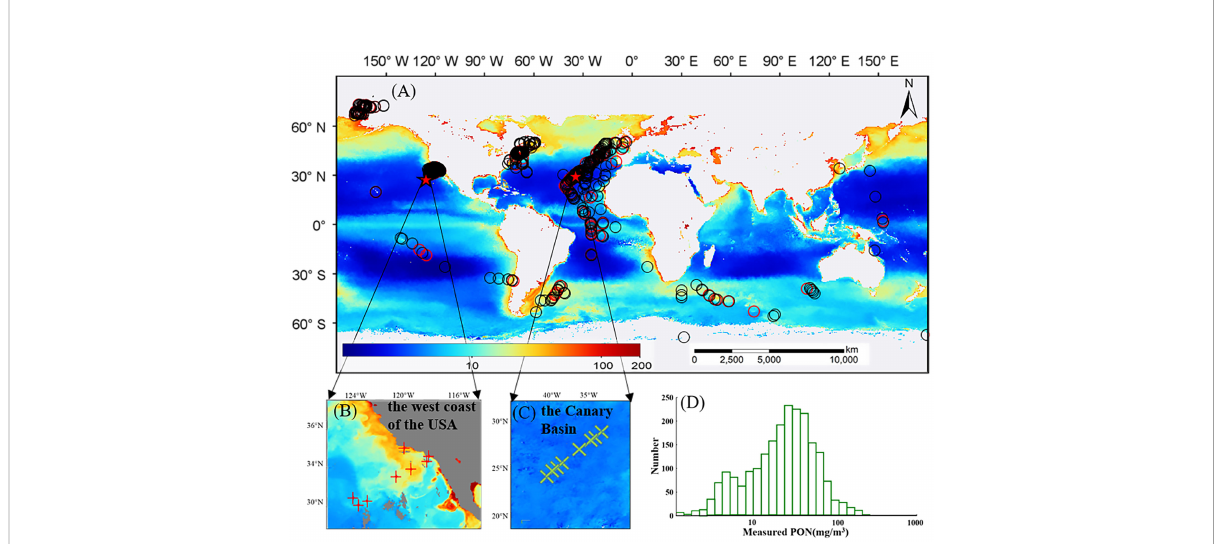
FIGURE 2 Geographical locations of matchups of in situ and satellite data (A) , and the histogram of PON concentrations of all matchups (D) . Modeling data and validation data are represented by black circles and red circles, respectively. Subplots (B, C) show matchups in these two regions used for further model evaluations. The background map in (A) shows the monthly climatology PON products generated from data from March 2009 to May 2016 by the NDNI